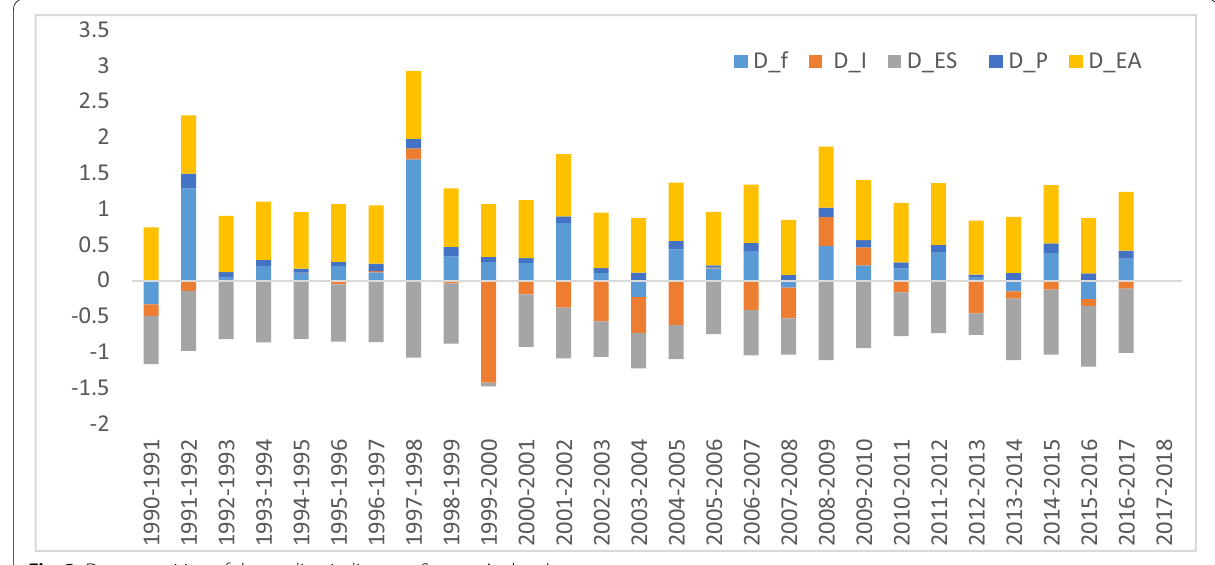
Fig. 3 Decomposition of decoupling indicators. Source: Authors’ construct